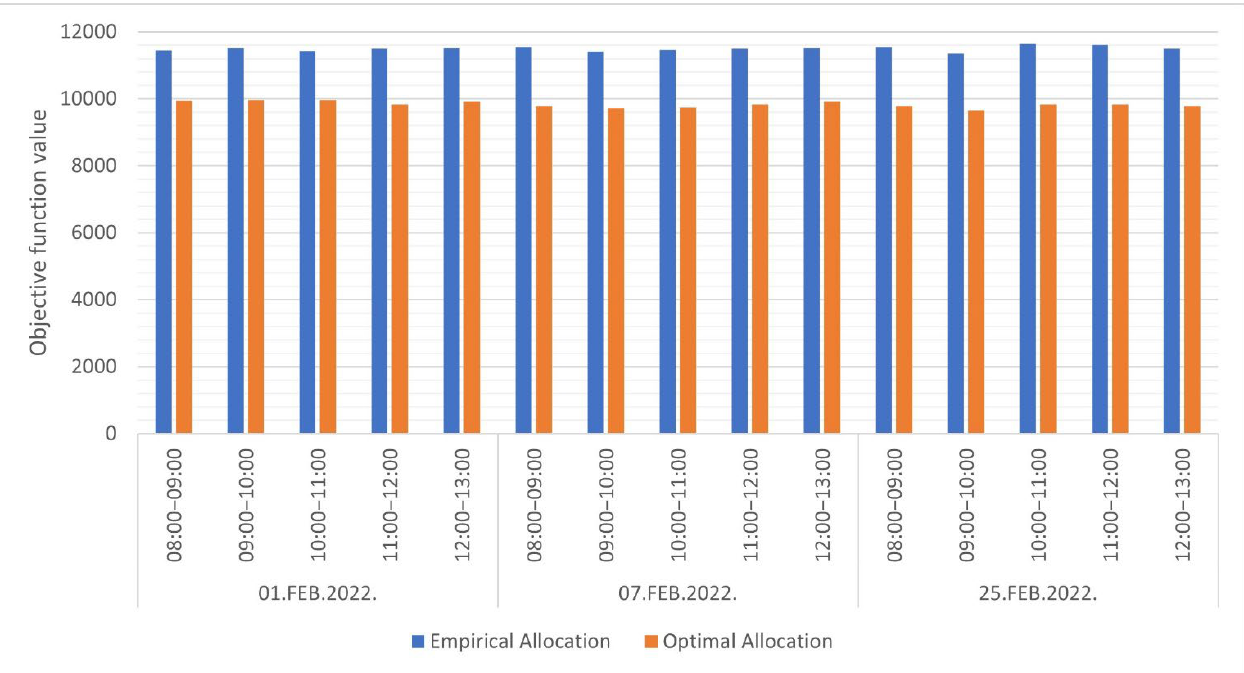
Figure 4. Objective function values across day - and time windows.